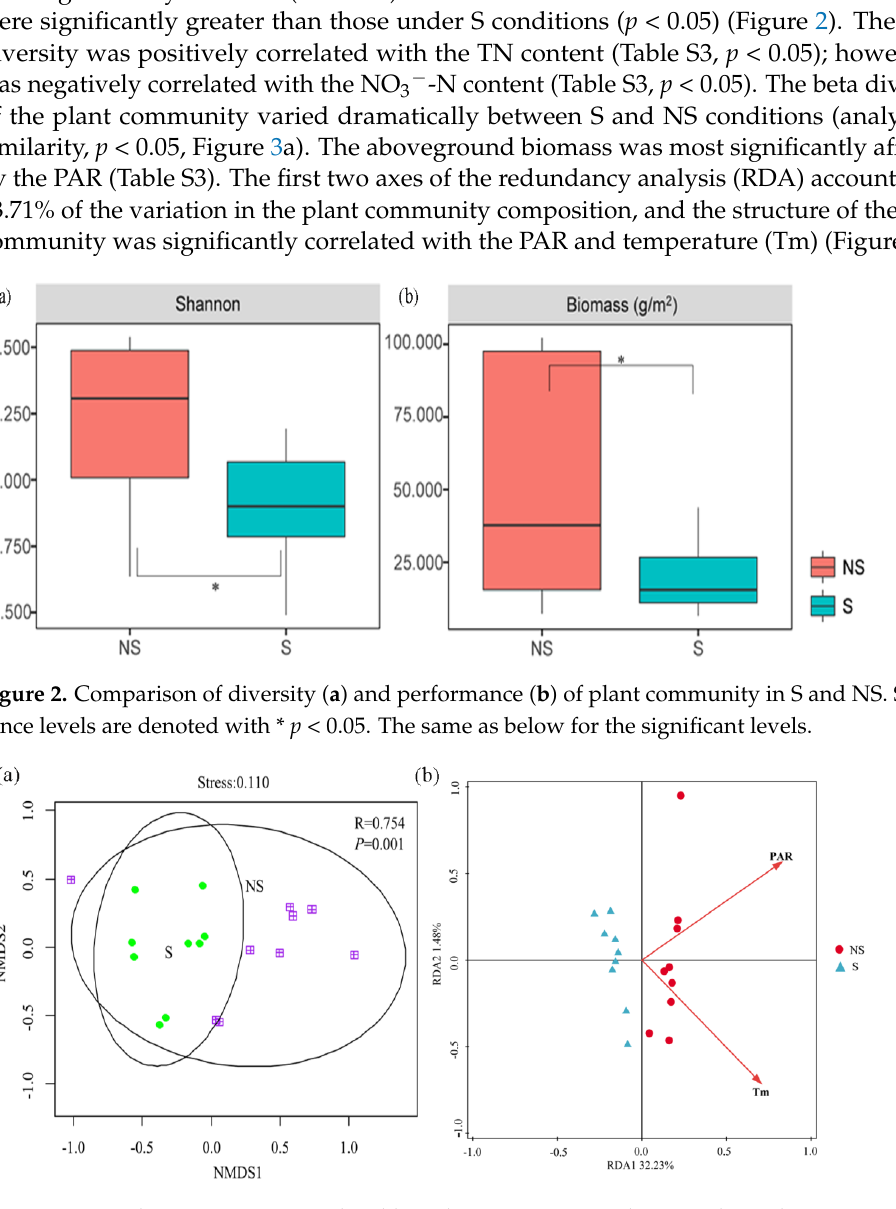
Figure 3. Beta diversity on species level based on Bray–Curtis distance through non-metric multidimensional scaling analysis ( a ) and redundancy analysis of environmental factors and plant community structure ( b ).